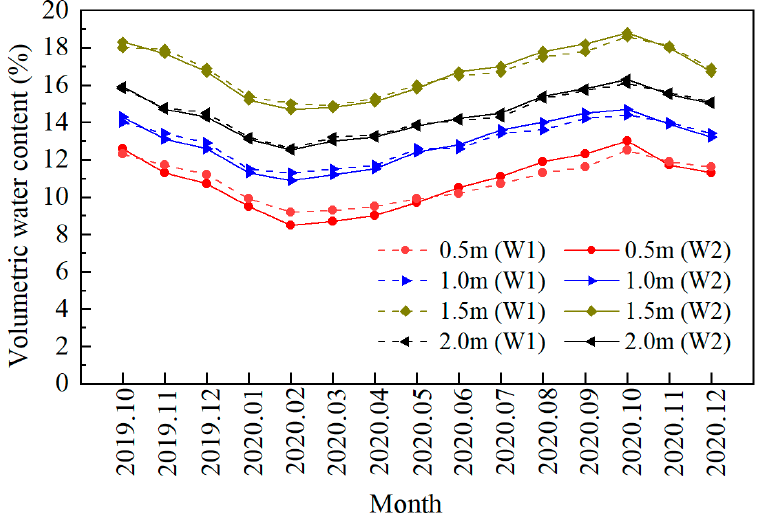
Figure 8. Variation of the monthly average volumetric water content of pro fi le W1 (with vegetation cover) and pro fi le W2 (no vegetation cover) at the same depth within 2 m underground.